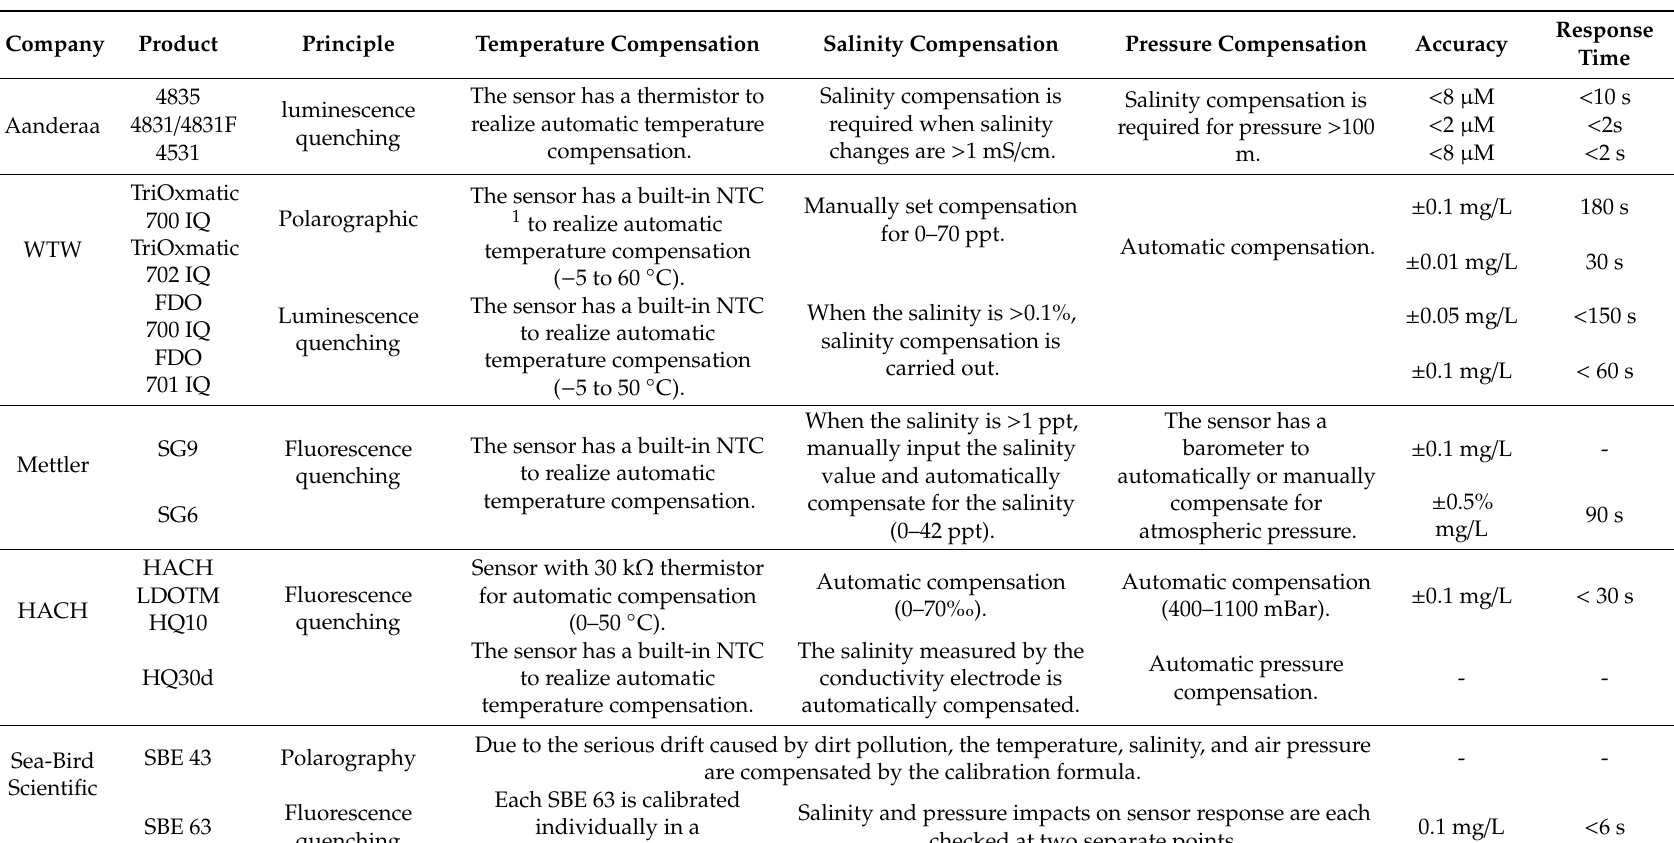
Table 6. Intelligent dissolved oxygen sensor